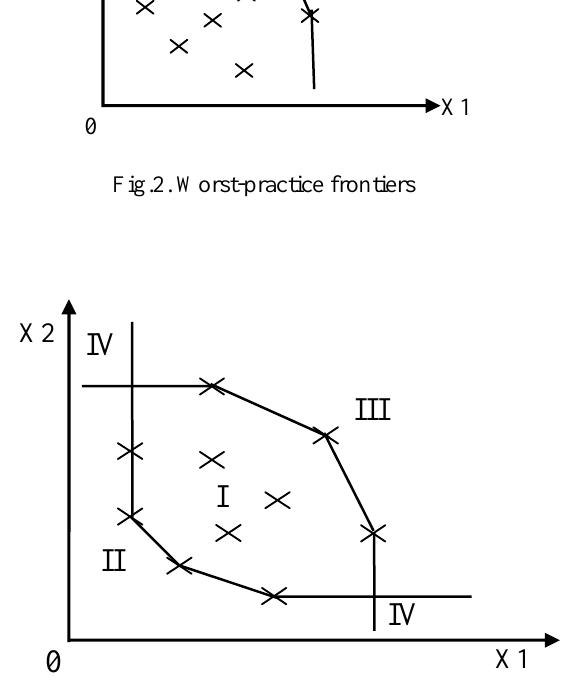
Fig.3. Four different locations of